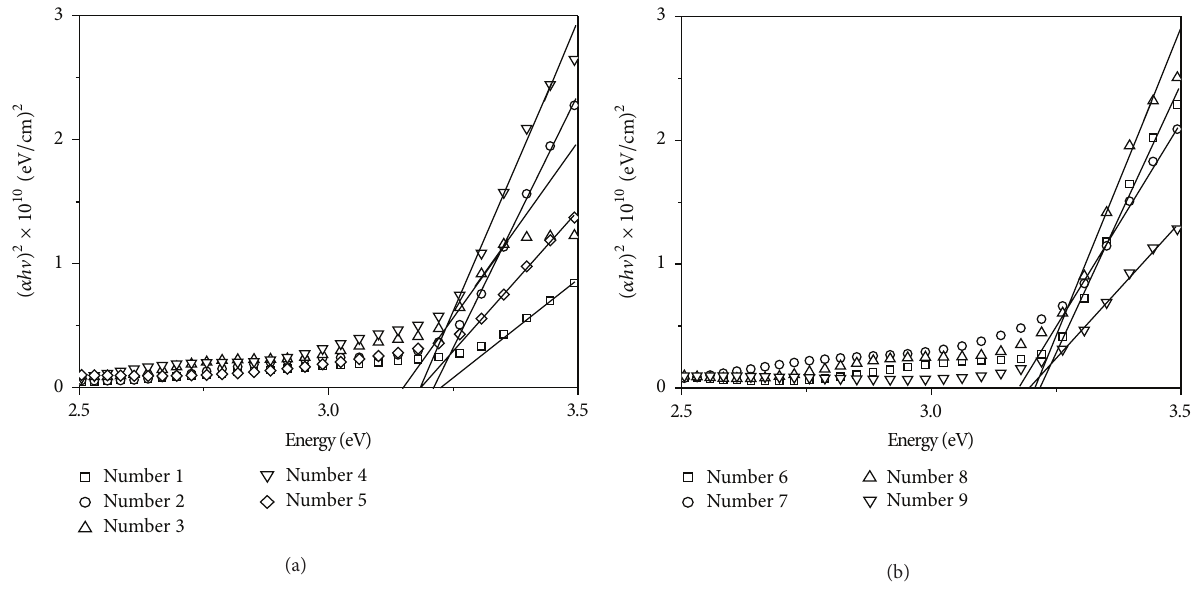
Figure 3: The optical energy gaps of the ZnO thin films; (a) experiments number 1 ∼ 5 and (b) experiments number 6 ∼